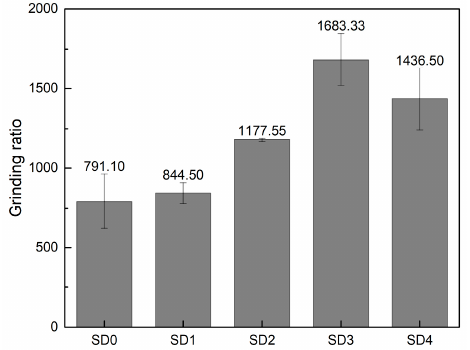
Figure 7. Results of grinding ratio test of impregnated diamond samples.